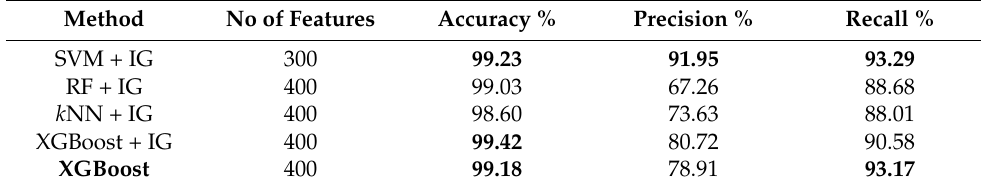
Table A2. Comparison of classification results for Data3.